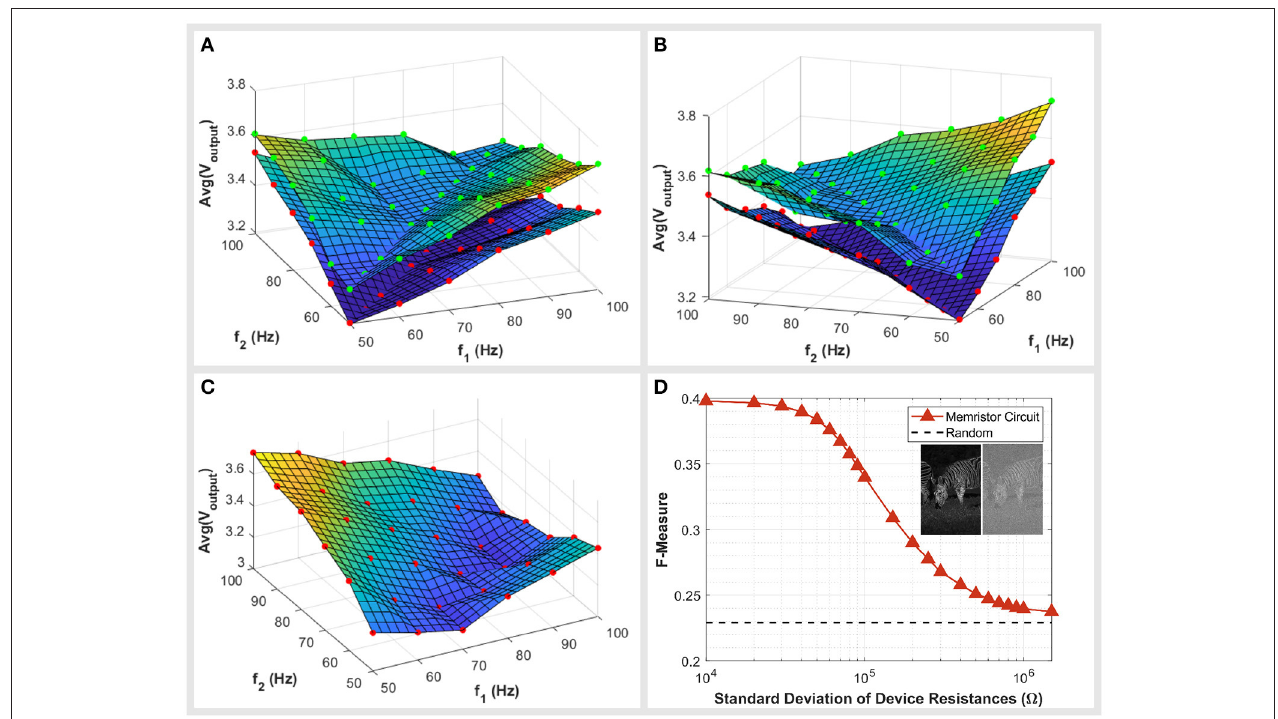
FIGURE 5 | (A,B) The circuit response plotted in two different perspectives for clarity. The response for two circuits are presented in both figures, a potential divider of two high resistance devices (red markers) and a potential divider of two low resistance devices (green markers). Markers represent the inputs sampled for the circuit. (C) The circuit response when devices have asymmetric resistances. The red markers indicate the points sampled from the circuit. (D) The effect of device variance on circuit performance. The circuit’s benchmark score (F-Measure) is plotted for a range of simulations where variations in device resistances were introduced. Device variations were distributed randomly and with a Gaussian distribution. The standard deviation of device resistances were increased with the effect of a reduction in performance. For reference the score of a system randomly categorizing pixels as edges is also